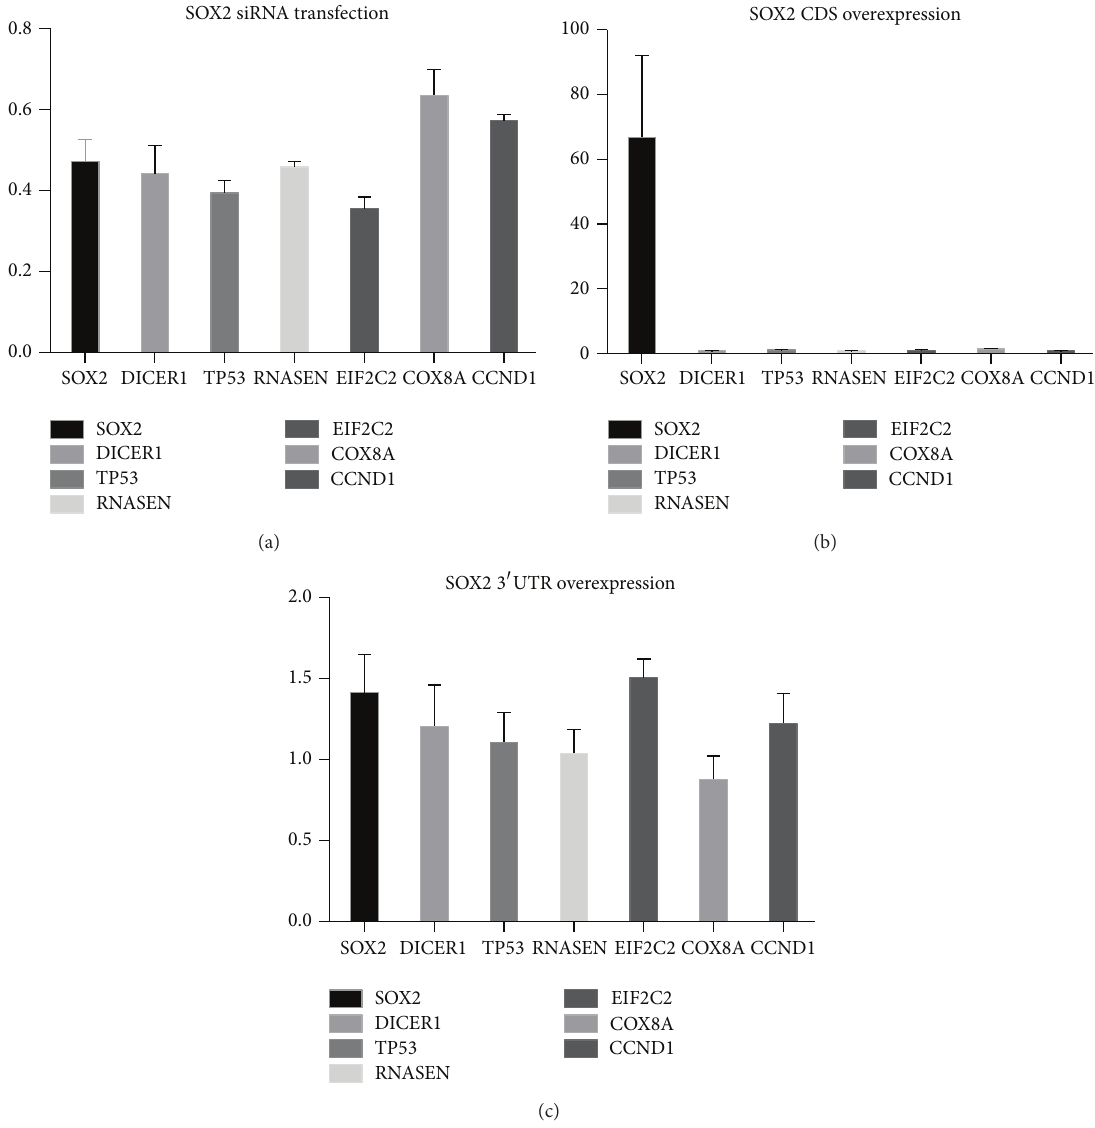
Figure 2: Example of SOX2 and SOX2 ceRNAs levels of transcription quantified by RT-PCR compared to controls and normalized against 𝛽 -actin expression in SW1736 ATC cell line. Whiskers represent the standard errors. (a) Analysis of SOX2 silencing. (b) Analysis of SOX2 coding sequence overexpression. (c) Analysis of SOX2 3 󸀠 UTR overexpression.